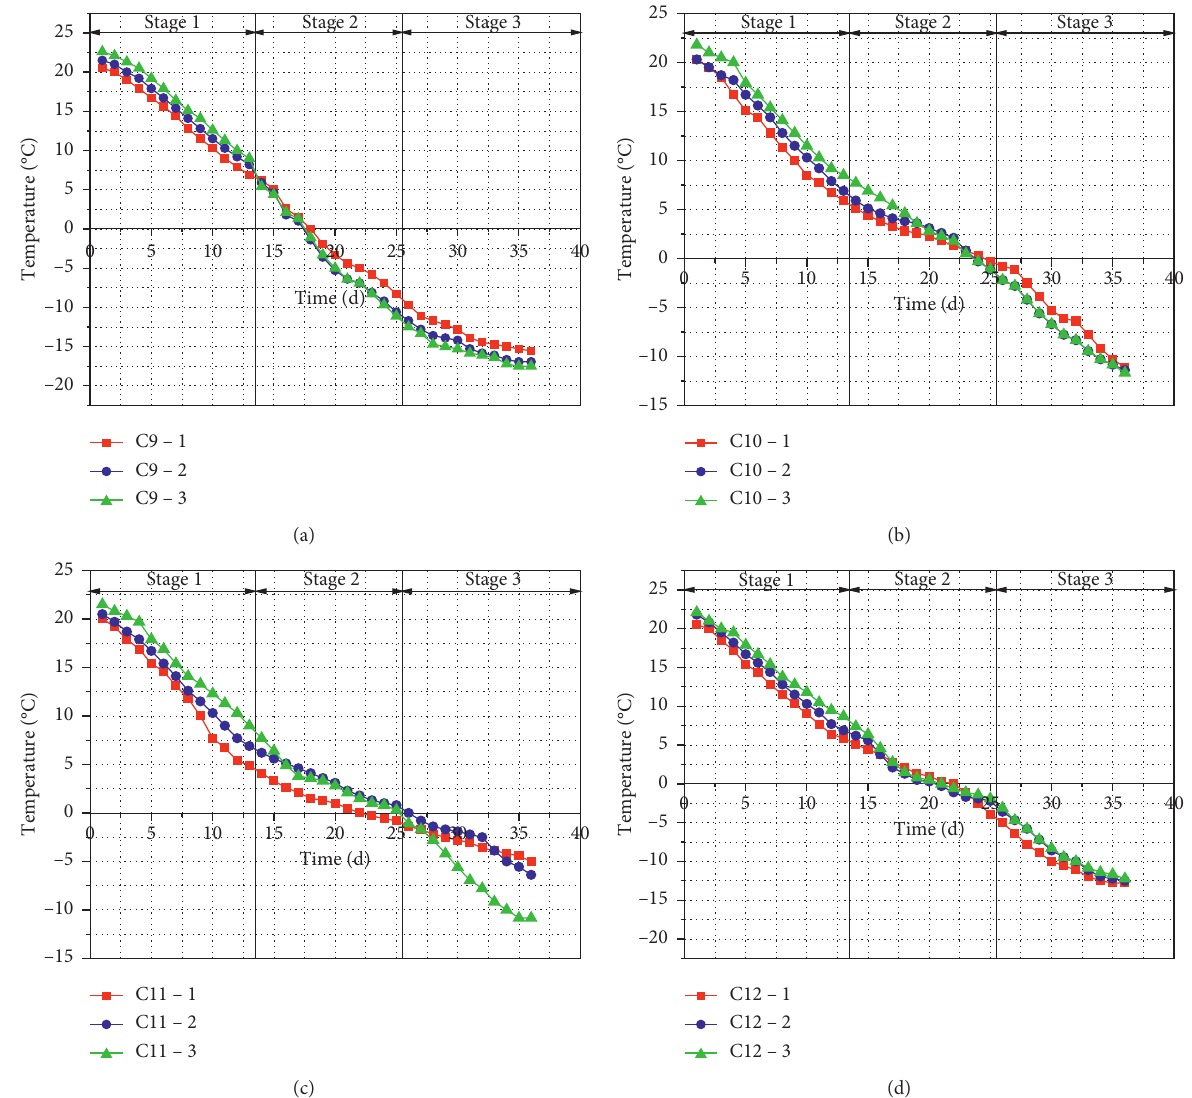
Figure 12: Correlation between the temperature of measuring points and freezing days: (a) C9, (b) C10, (c) C11, and (d)